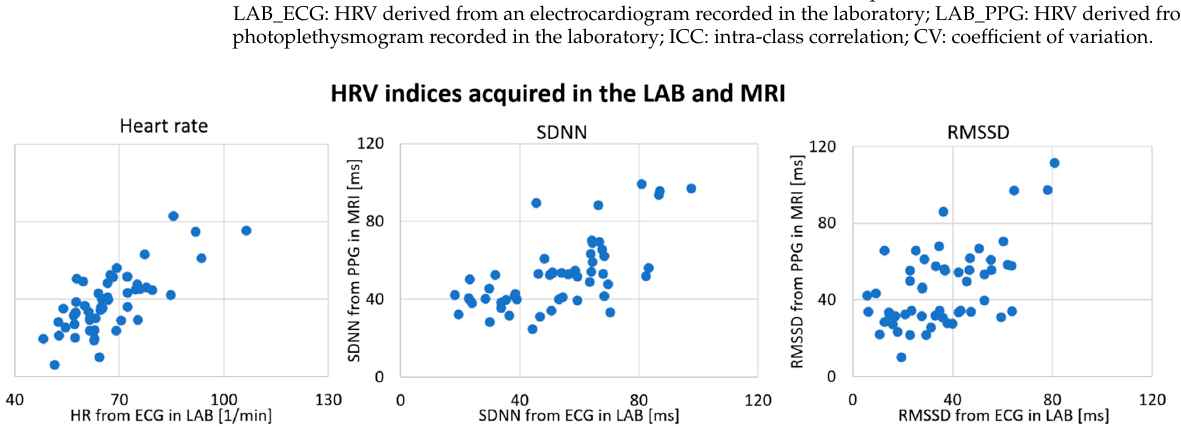
Table 3. HRV indices derived from photoplethysmogram recordings in the laboratory and during MRI compared to electrocardiograms in the laboratory (N = 55).